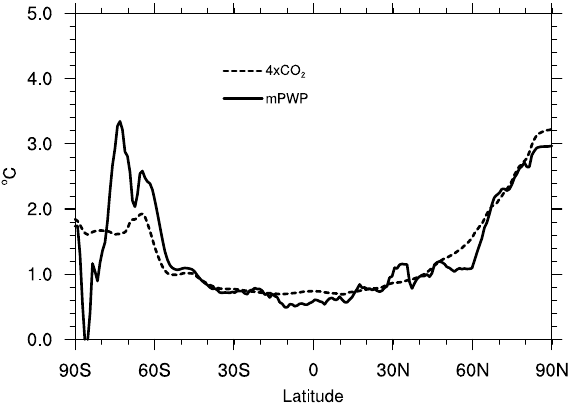
Fig. 11. Zonally averaged MAT anomaly normalized by the global MAT anomaly for the mPWP (solid line), and abrupt 4 × CO 2 sce- nario simulations with CCSM4 (dashed